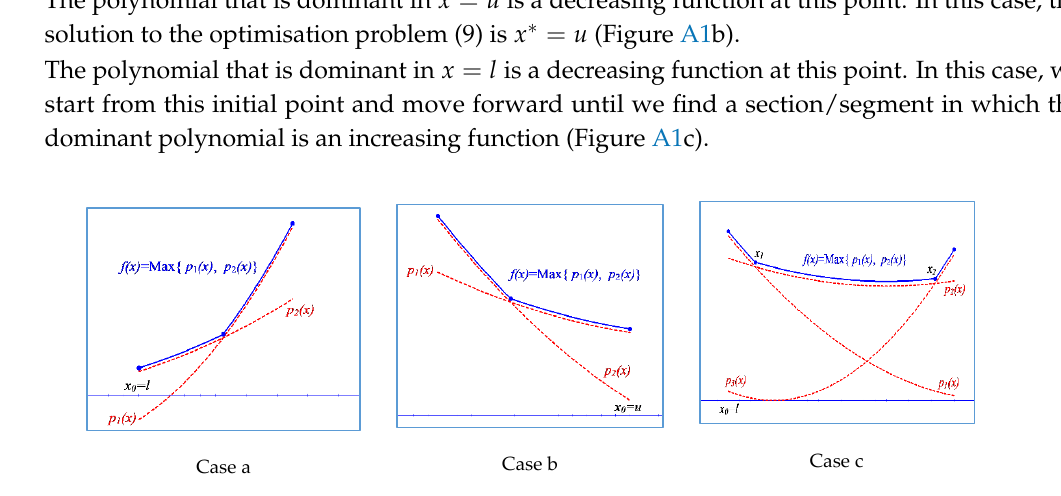
Figure A1. Graphical representation of the three cases.